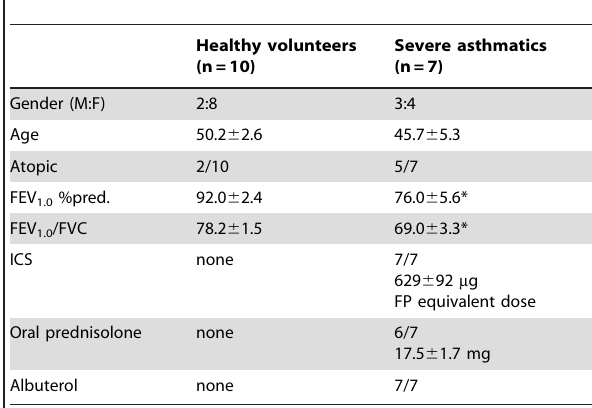
Table 1. Characteristics of